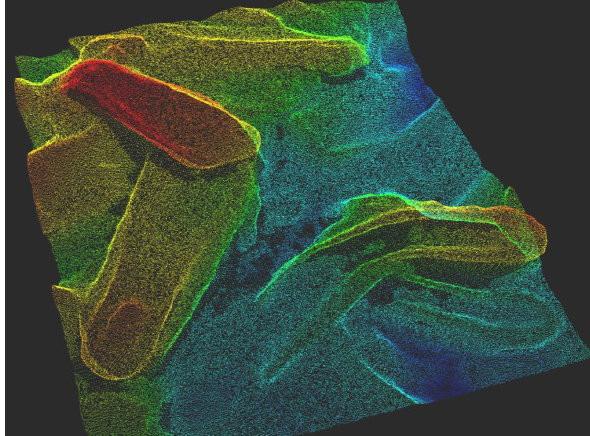
Figure 2. 3D Point cloud of a few shells (convex down) originally on the oyster reef surface; 70 cm by 50